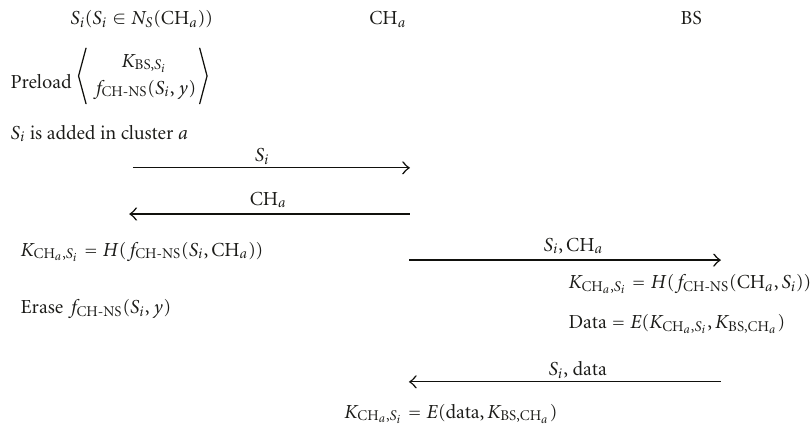
Figure 2: Protocol illustration of adding a new sensor node when BS is